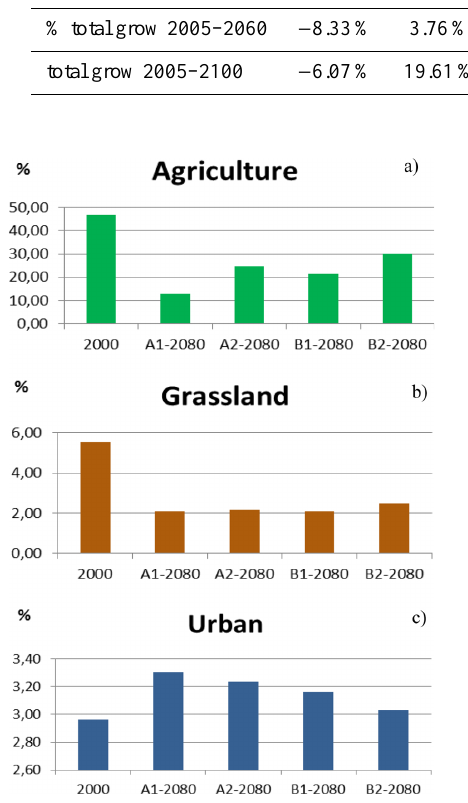
Figure 6. Local scenarios for land use change for: (a) agriculture, (b) grassland and (c) urban. Source: Adaptaclima-EPAL project re- port (2011).